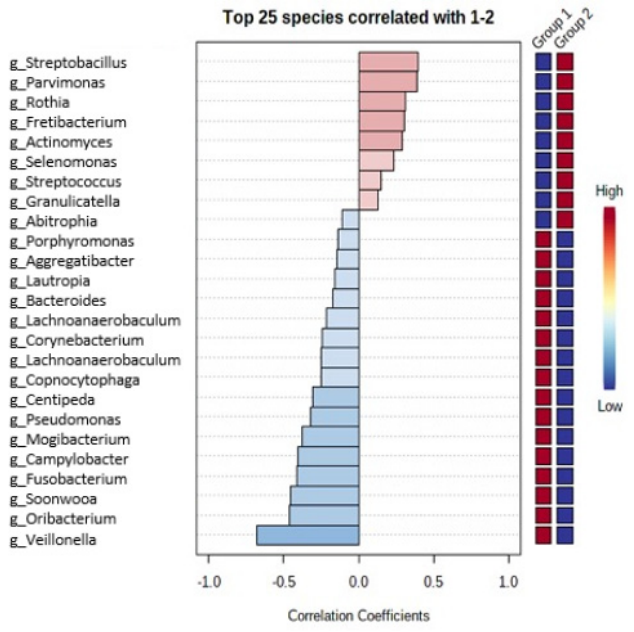
Figure 1. Differences in oral microbiota between group 1 vs. group 2.